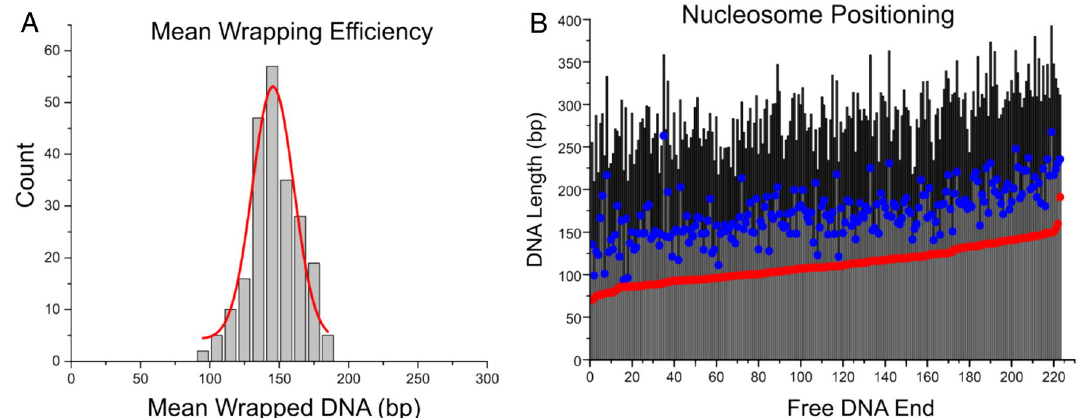
Figure 5. Mean wrapping efficiency and positional mapping of canonical dinucleosomes assembled on the substrate with two positioning motifs. Histogram ( A ) mean value of 146 ± 1 bp (SEM), which closely corresponds to the canonical value of 147 bp. ( B ) Positional mapping of canonical dinucleosomes demonstrates preferential positioning for both